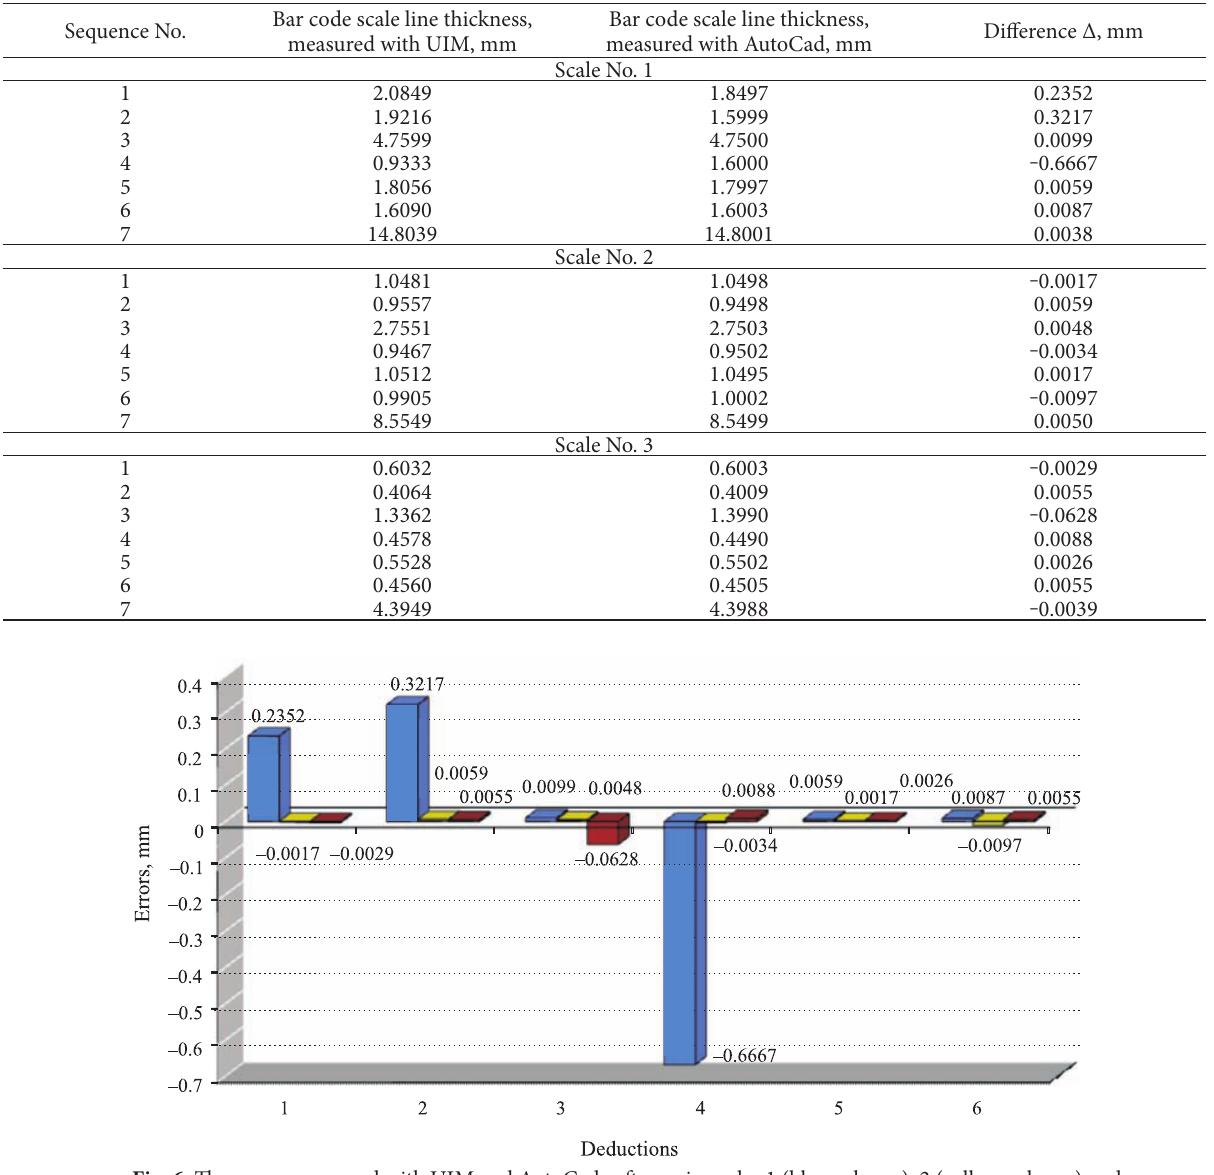
Fig. 6. The errors measured with UIM and AutoCad software in scales 1 (blue column), 2 (yellow column) and 3 (red column)